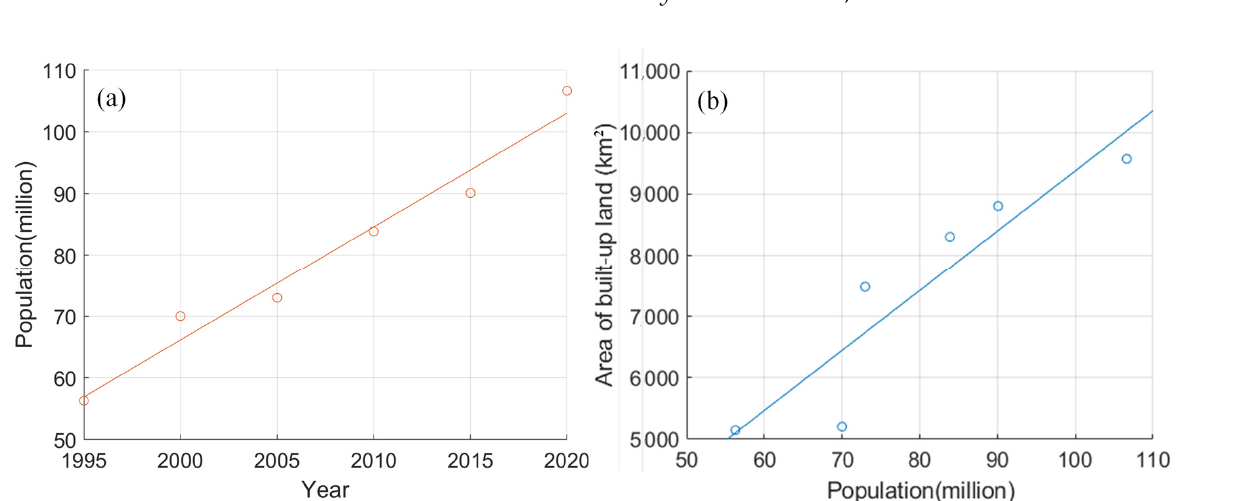
Figure 5. Linear regression of the population over time in the GBA ( a ); linear regression of the area of built-up land over population ( b ).